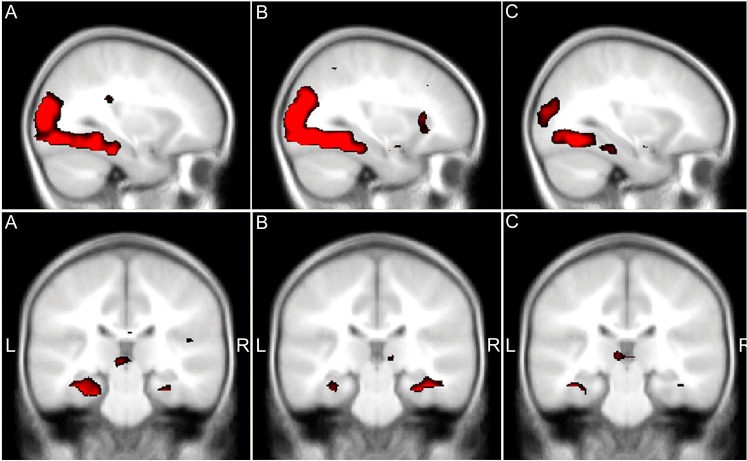
BOLD activation.BOLD activation maps related to encoding novel pictures of the picture encoding task. Upper part: sagittal cross-sections (x = -30, y = -90, z = -9) in AGA (A), SGA+ (B) and SGA- (C) children, representing the left ventral stream with significant activation from the occipital lobe via the fusiform gyrus into the parahippocampal gyrus/hippocampal formation. Functional results are thresholded at p<0.005 for display purposes. Lower part: Coronal cross-sections of the parahippocampal gyrus/hippocampal formation area (x = -21, y = -27, z = -24) in AGA (A), SGA+ (B) and SGA- (C) children. Images thresholded at P<0.005 for display purposes. AGA = average for gestational age, SGA+ = small for gestational age with catch-up growth, SGA- = small for gestational age without catch-up growth.